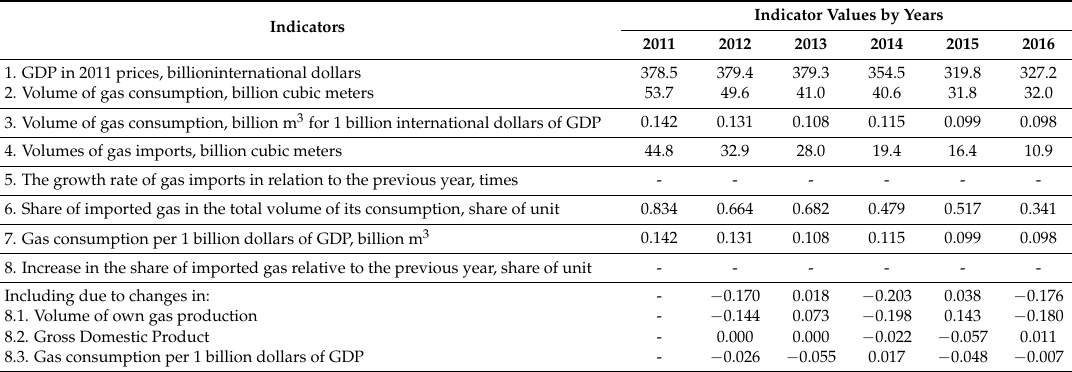
Table 8. Indicators for assessing the adaptability of the Ukrainian economy to the risks of insufficient supply of natural